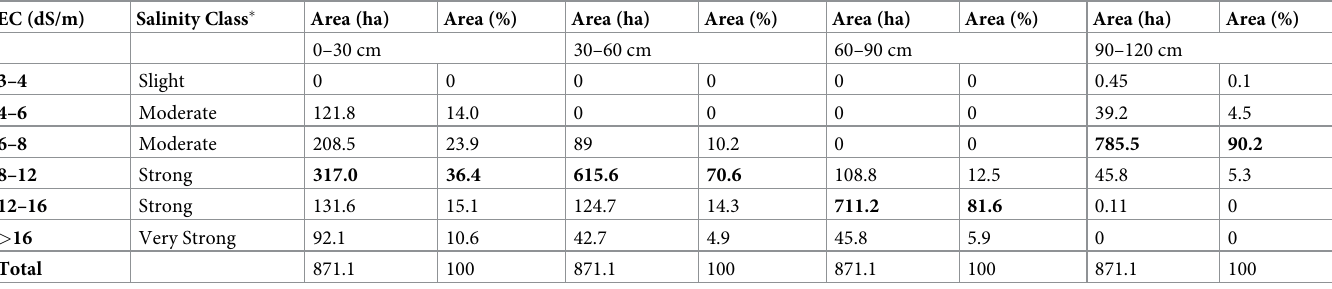
Table 5. Salinity classes and coverage area of salinity zones in the study area.